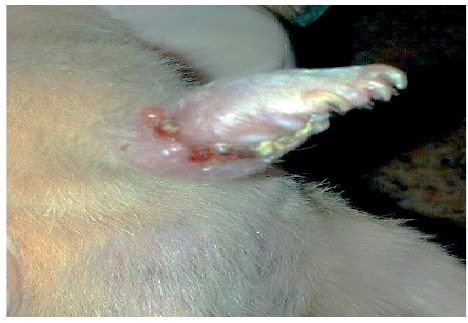
Figure 1. Lesion caused by Leishmania major infection in a female hamster right foot pad.